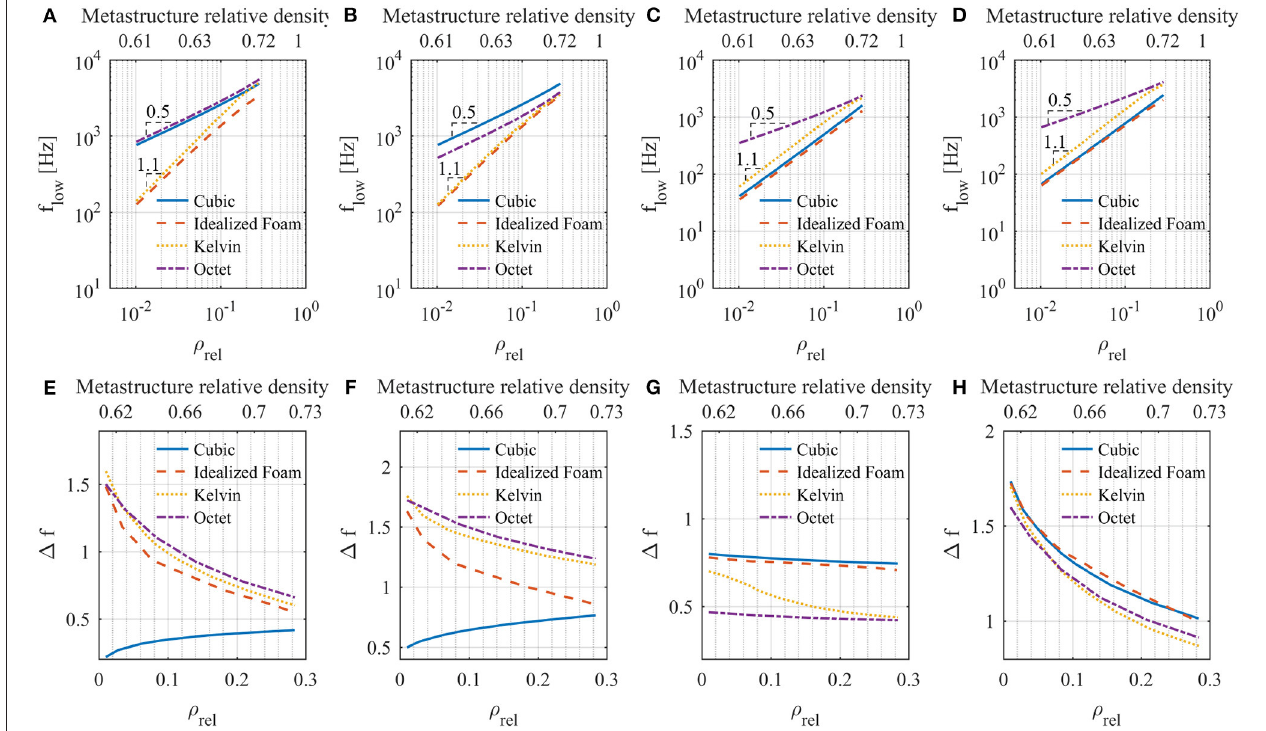
FIGURE 8 | Dynamic performance parameters for all polarizations. (A) Full f low . (B) Axial f low . (C) Bending f low . (D) Torsional f low . (E) Full ∆ f . (F) Axial ∆ f . (G) Bending ∆ f . (H) Torsional ∆ f . Metastructure relative densities are shown for